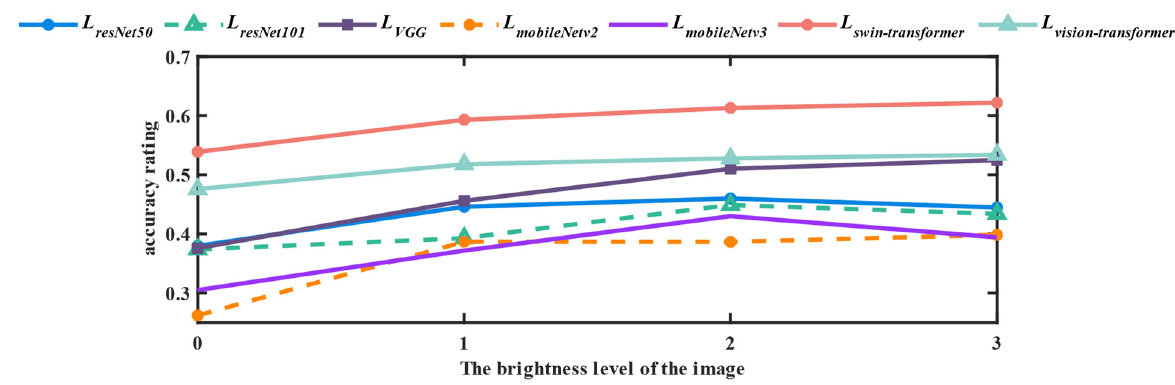
Figure 5. Accuracy diagram of backbone network under different brightness addition.